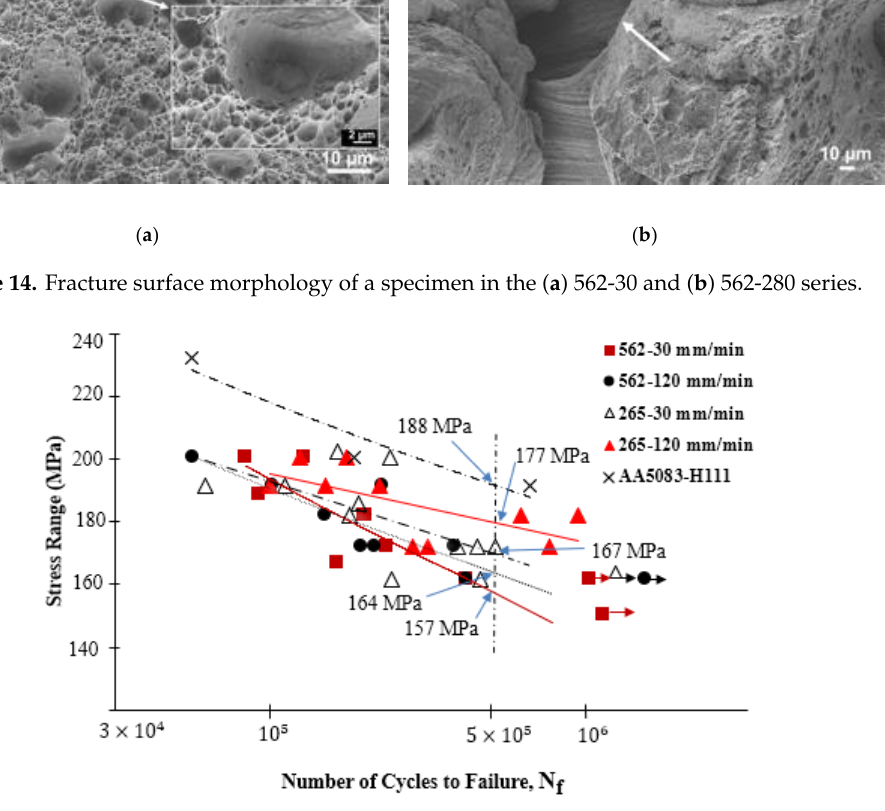
Figure 15. Influence of welding speed on the fatigue strength of the 562 and 265 series.